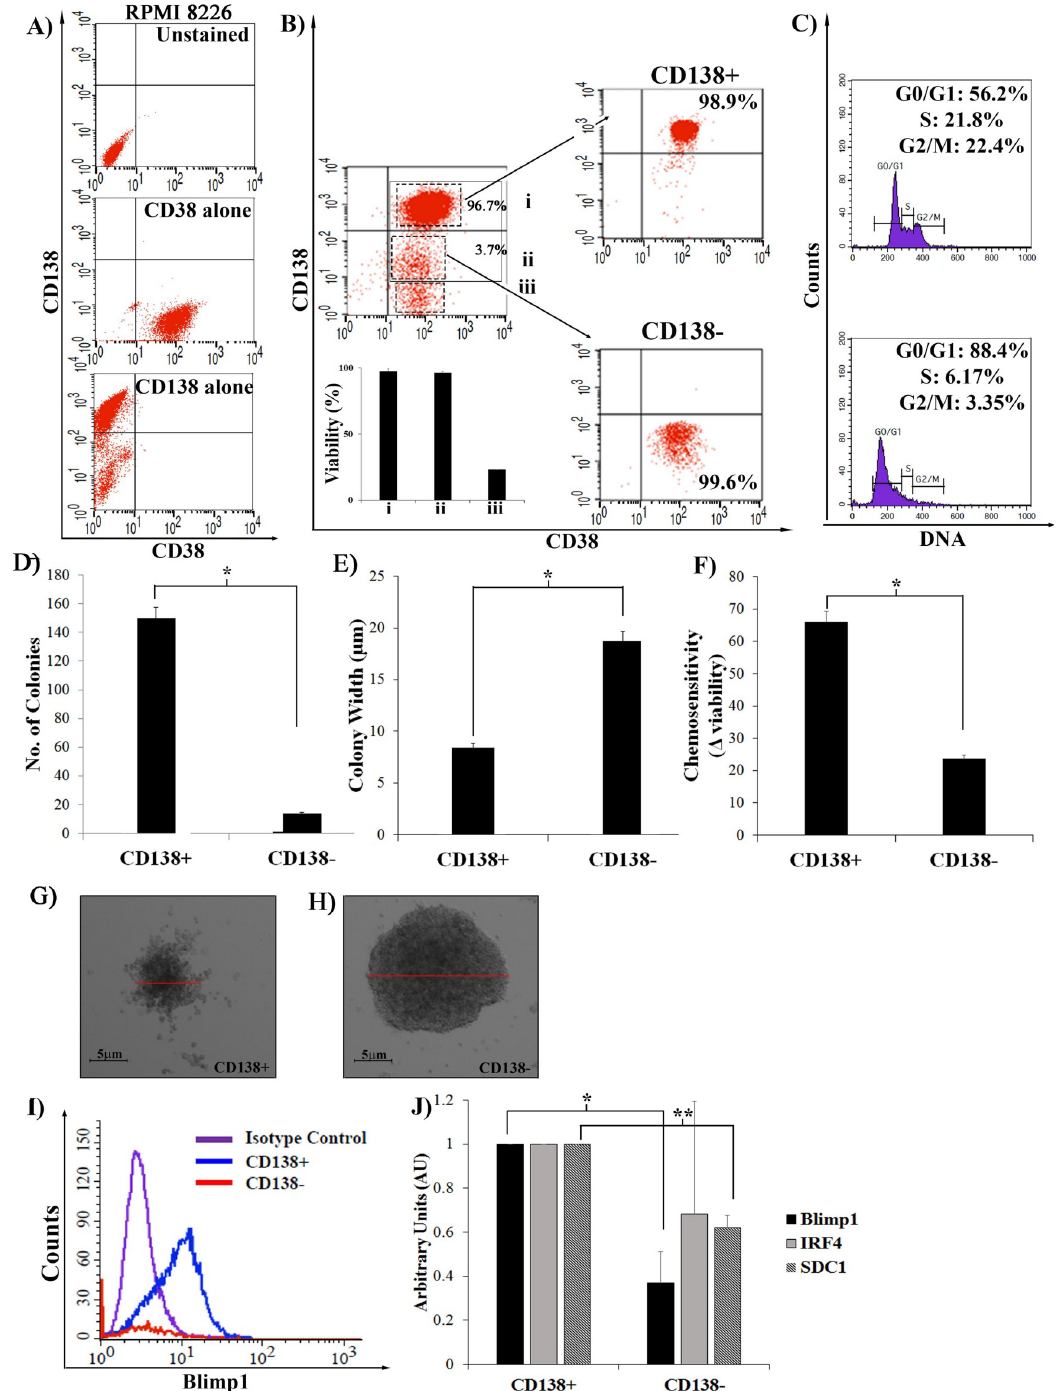
Fig 1. Stemness of RPMI 8226 cells. A) Cells analyzed by flow cytometry as unstained, CD38 or CD138 single stained populations to establish gates for double-stained populations. B) Cells co-stained with CD138 and CD38, and sorted into CD38+CD138+ (i), CD38+CD138- (ii), CD38+CD138null (iii) populations with high efficiency. ( Inset ) Viability of each population, as measured by trypan blue staining and plotted as viability seen in population i (CD38+CD138+). C) Each sorted, pure population was independently fixed in ethanol and stained with Vybrant Green and analyzed using CellQuest software to measure cell cycle status. D,E) CD138+ and CD138- sorted cells were plated in methylcellulose for 14 days, colonies were counted and widths measured. (n = 4) � p < 0.001, F) Each sorted population was treated with 0.01 μ M Bortezomib for 24 h and chemosensitivity measured as